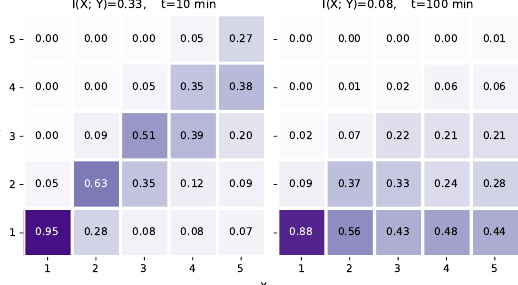
Figure 2. The conditional distributions P ( Y | X ) of two precipitation nowcasting tasks on one dataset. Left: Task predicting future radar echo intensity in the next 10 min. Right: Task predicting future intensity in the next 100 min. The radar echo intensity (0–70 dBZ) is evenly divided into five categories, and the X and Y axes stand for the index of each category. The value in each cell represents the corresponding joint probability P ( Y | X ) . Take 0.95 in the bottom-left corner of the left image as an example: if the current intensity is in category 1 (0–14 dBZ), the probability that the intensity in 10 min is still category 1 is